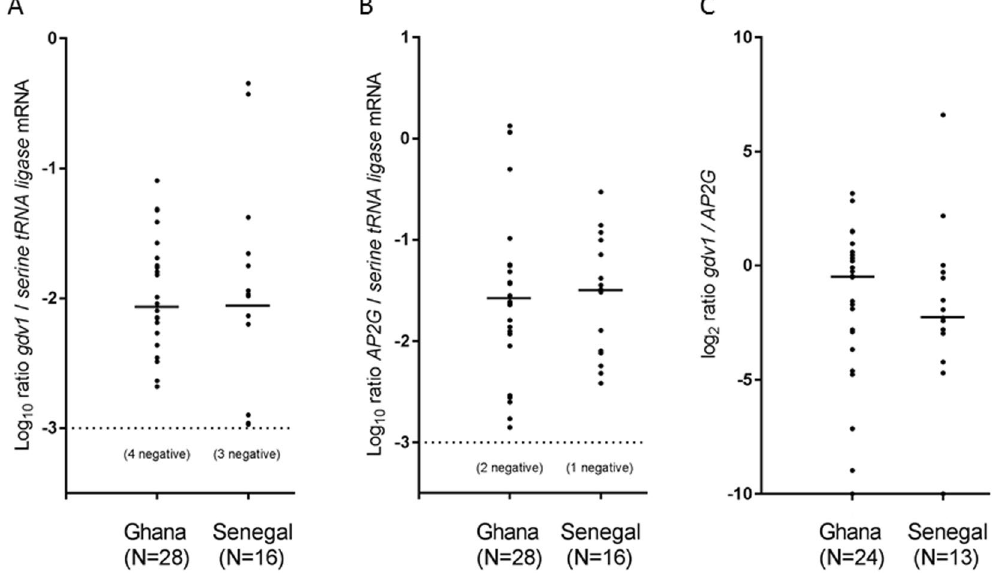
Figure 6. Estimation of gdv1 and AP2G transcripts in 44 individual P. falciparum clinical infection samples from Ghana and Senegal as measured by RT-qPCR using primer pairs within each coding sequence. ( A ) Ratios (Log 10 ) of gdv1 to a housekeeping gene ( serine tRNA ligase ) show a wide spectrum that is similar in each population. ( B ) Ratios